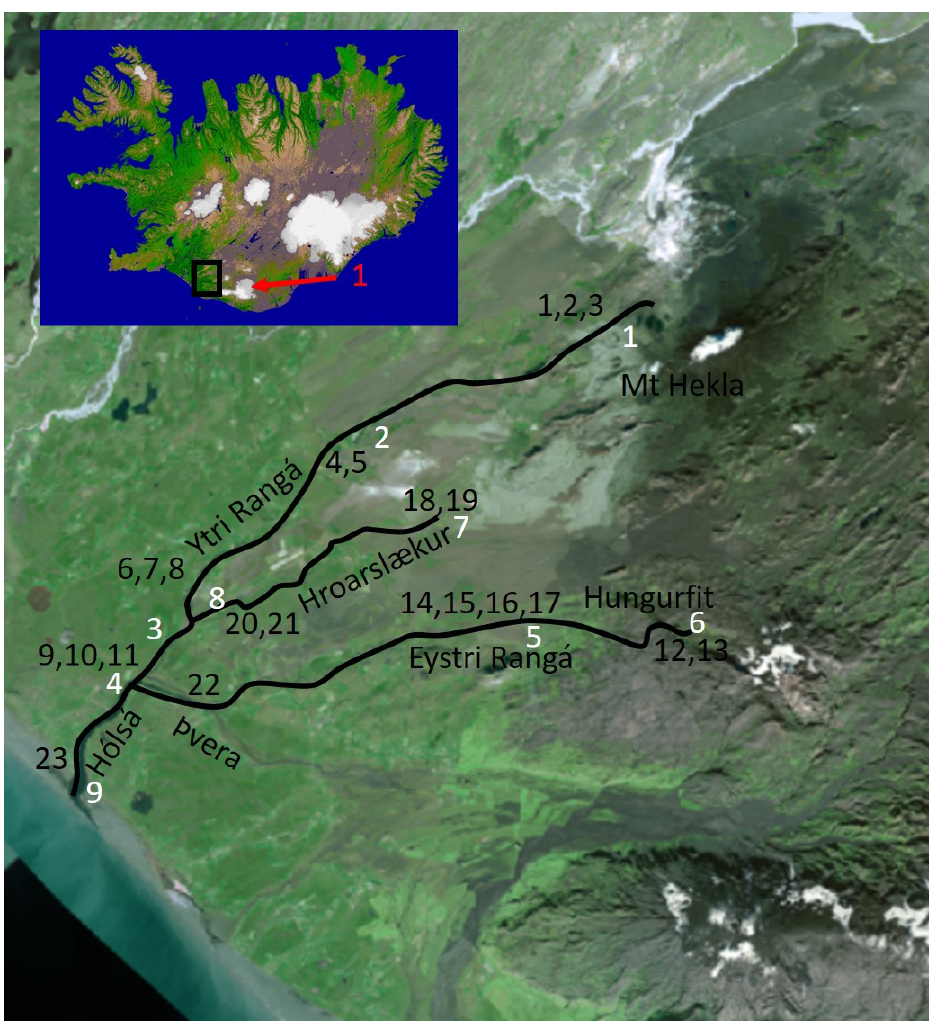
Figure 1. Rangárvellir study area. Black numbers indicate the location of collected sediment samples, white numbers indicate soil sampling location and the red number in the inlet map locates the ash sampling location (see Table 1 for further details).